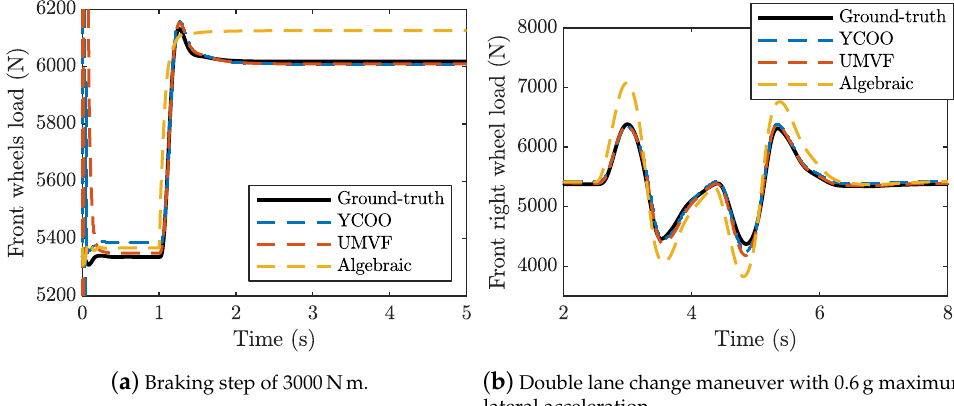
Figure 5. Vertical tire force estimation on maneuver with longitudinal and lateral only